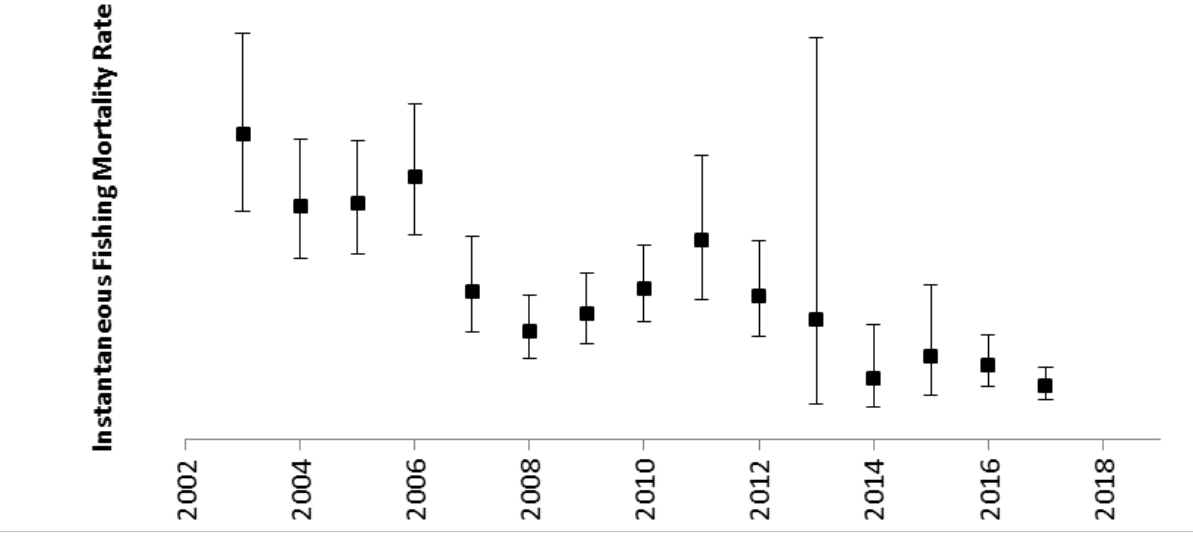
Figure 3. CMSA model estimated instantaneous fishing mortality rate F with lower and upper 95% confidence limits. Y-axis values have been removed due to CONFIDENTIAL